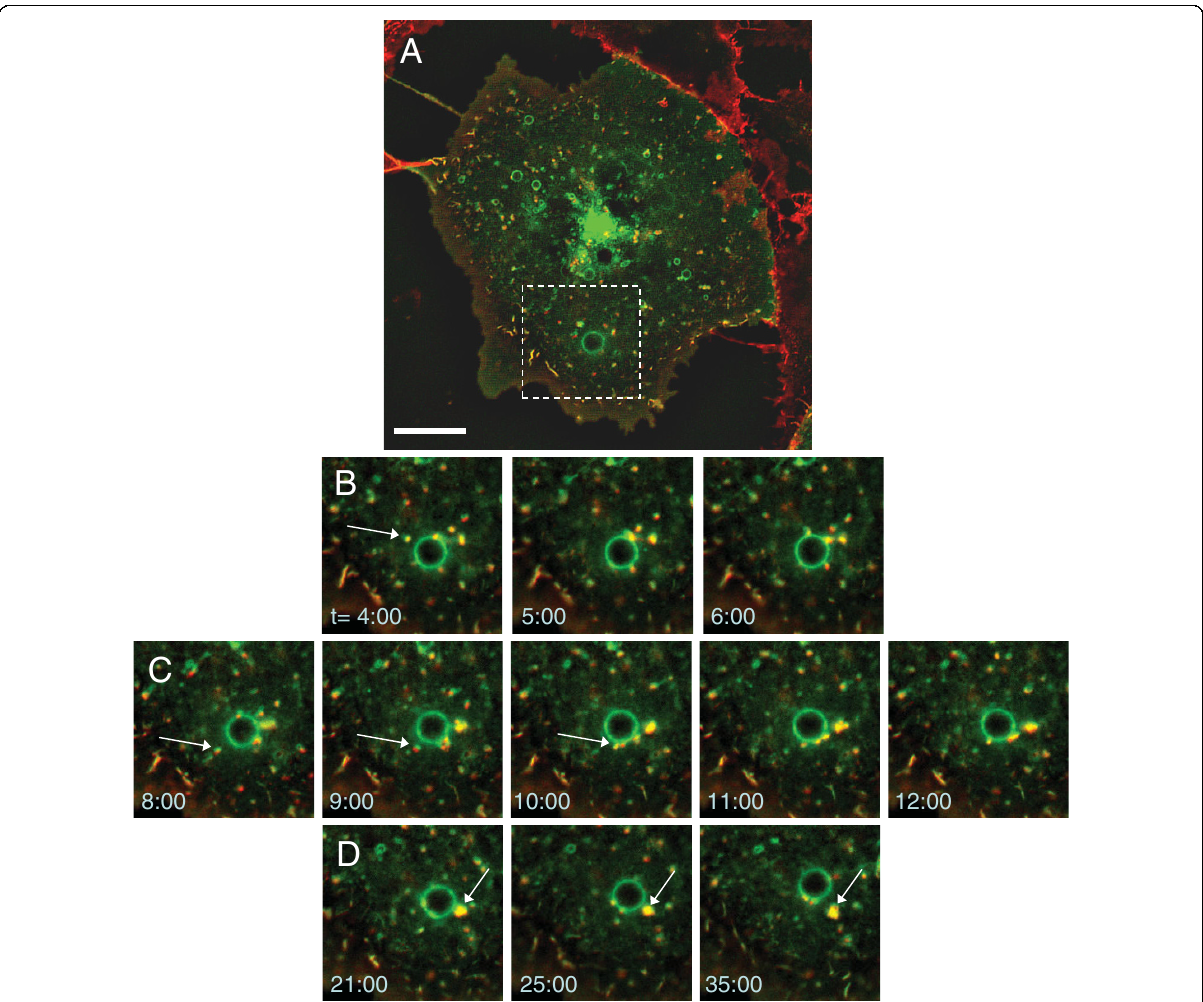
Figure 6 b 1 -integrin traffics through R-Ras-positive vesicles . Time course images of (A) a GFP-R-Ras(wt) transfected Cos7 cell incubated in Alexa Fluor555 (red) labeled b 1 -integrin antibody solution for 30 mins reveal the interplay of R-Ras and b 1 -integrin (See Additional file 8, Movie S5). (B, C) The inset of images from the boxed region in A acquired at one minute intervals show that R-Ras and b 1 -integrin traffic together to large endosomal vesicles. (D) Endocytosed components are then repackaged together and bud off from these organelles. Scale bar is 20 μ